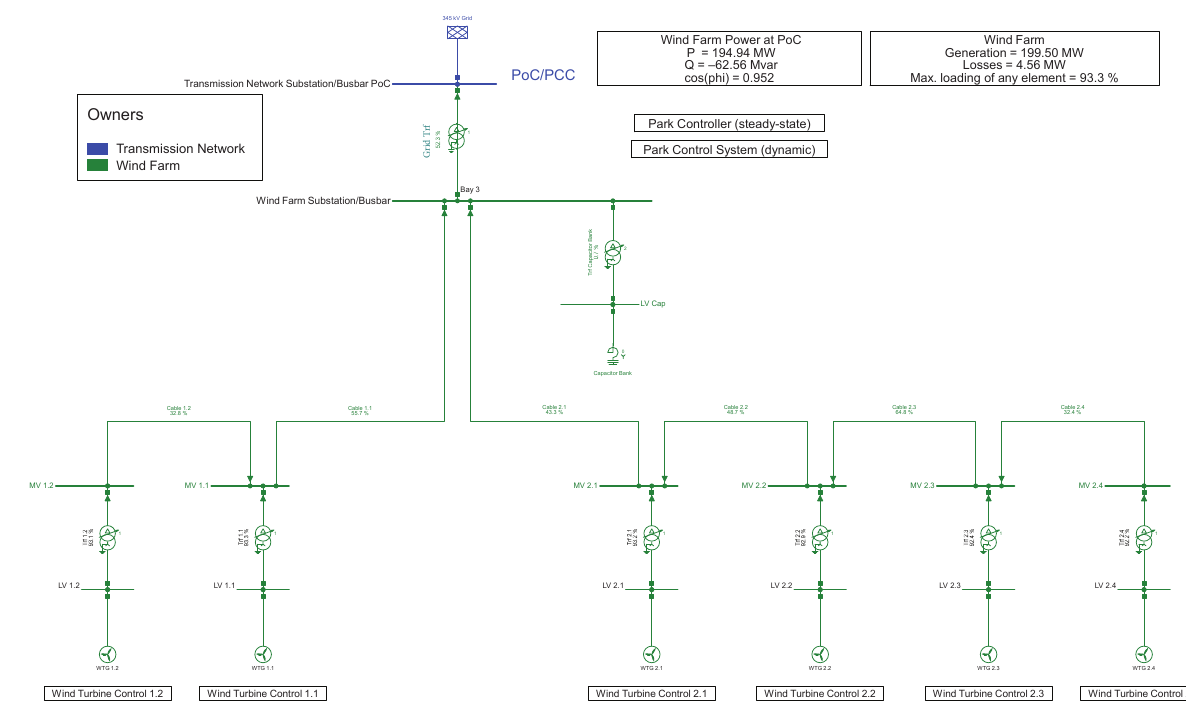
Figure 4. DIgSILENT model of Wind Park POC: Point of Conection, PCC:Point of common coupling.